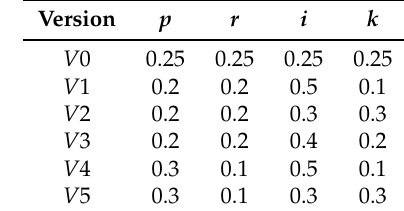
Table 3. The tested weighing system for intrinsic vulnerability mapping of Fontaine de Vaucluse.